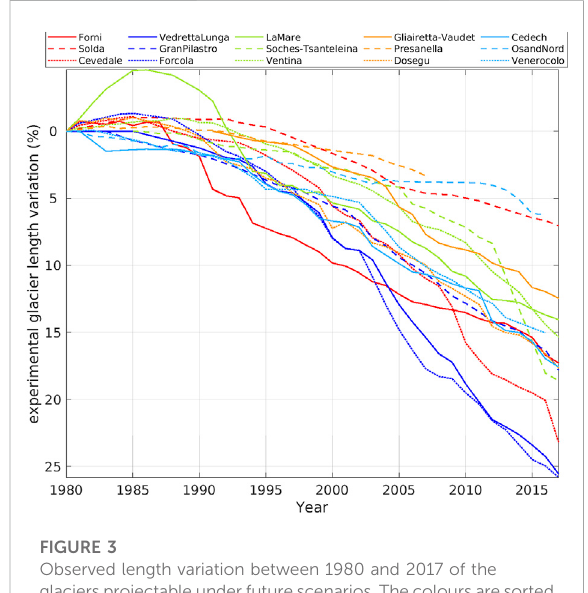
FIGURE 3 Observed length variation between 1980 and 2017 of the glaciers projectable underfuturescenarios. Thecolours aresorted from the longest (red) to the shortest (light blue)